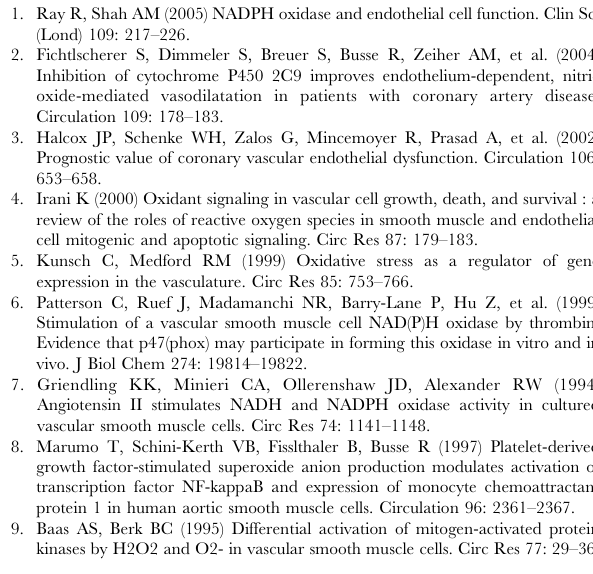
Figure S1 VEGFR-2 from different species demon- strates conservation of cys 1201 and cys 1208 in the cytoplasmic tail. (TIFF) Figure S2 VEGF-induced thiol oxidation in PLC c -1 does not require NADPH oxidase-derived ROS. Cysteinyl labeling assay to Identify thiol oxidation of PLC c -1 in VEGF- treated (50 ng/ml for 2 mins) HCAEC lysates using biotinylated IAP probe. HCAEC were transfected with Scram-si or si-p47 phox as indicated. After cell lysis in the presence of IAA followed by DTT treatment and IAP labeling, 1.5 mg biotinylated protein lysates were subject to immunoprecipitation using Streptavidin- agarose beads and immunoblotted using anti-PLC c -1 antibody. (TIF) Figure S3 Colocalization of internalized VEGFR-2 with EEA-1-positive early endosome is redox-sensitive. HCAEC transfected with control (Scram-si) (A) or si-p47 phox (B) were double labeled for internalized VEGFR-2 (green) and EEA-1 (red). Internalized VEGFR-2 was labeled for immunofluorescence assay as described in the Legend of Figure 4A and is shown here in green. EEA-1 positive endosomes were labeled with Alexa- Fluor647-conjugated secondary antibody and is shown in red. Nuclei were stained with DAPI (blue). (C) Bar graphs show image analysis for colocalization events using the NIH Image J plugin as described in the Legend of Figure 4B. The graphs present the number of colocalization events normalized for the number of VEGFR-2–positive compartments. Values are the mean of three experiments 6 S.E.M., each containing numbers obtained from five random fields. * p , 0.05 was considered statistically